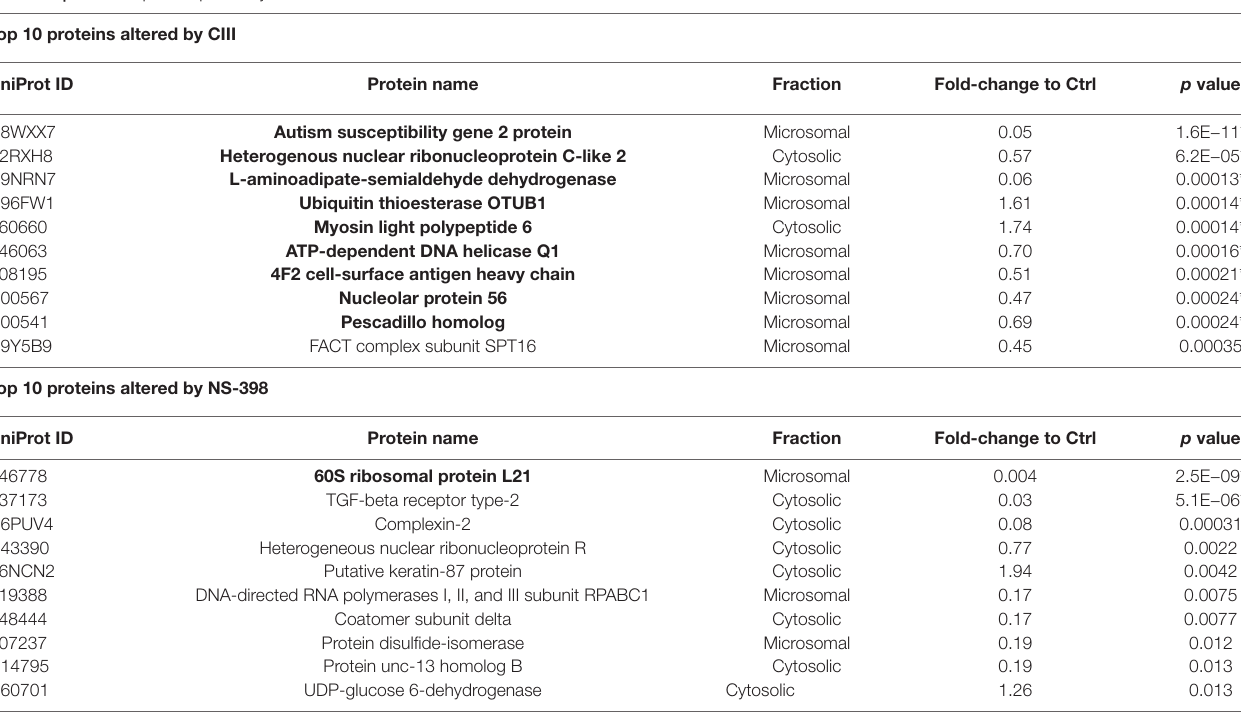
TABLE 1 | Effect on protein profile by CIII and NS-398. Top 10 proteins altered by